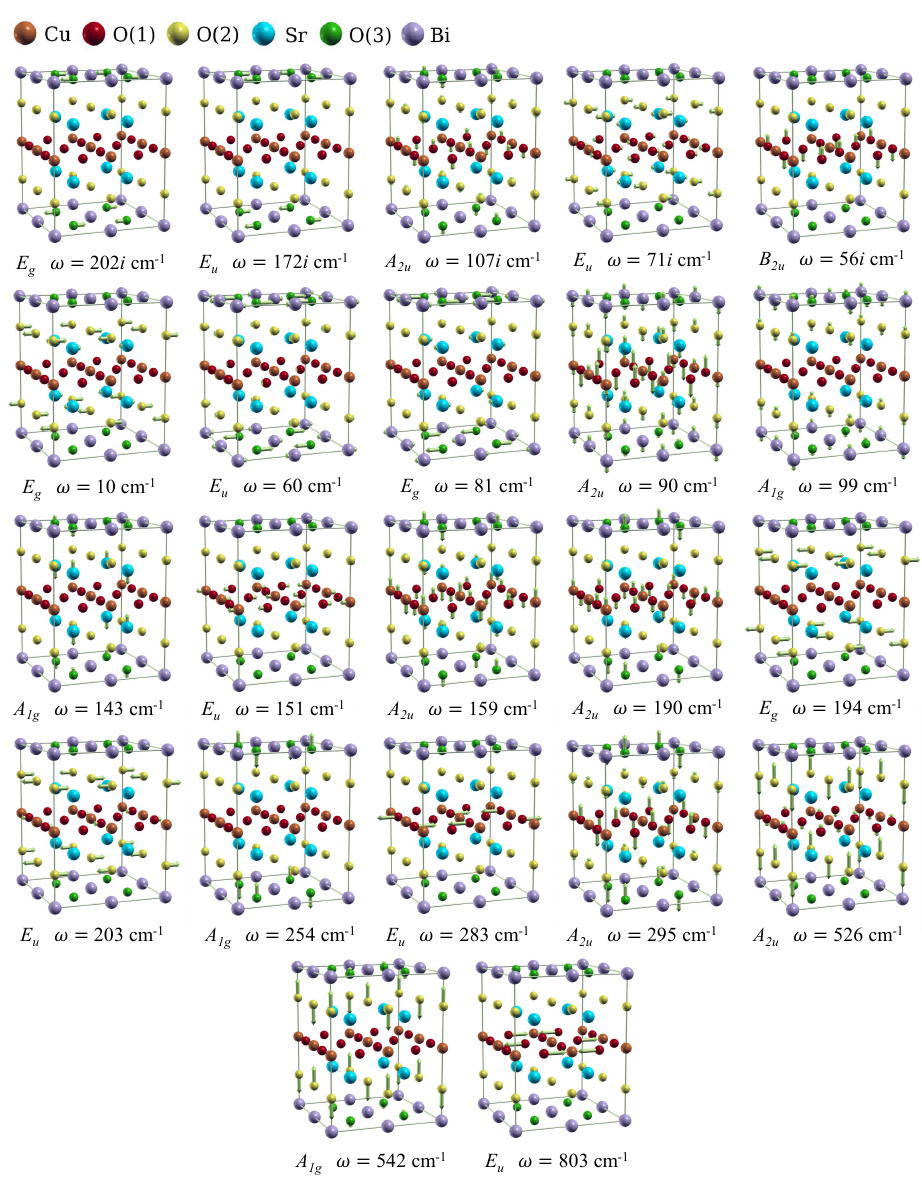
Figure A6: All Bi2201 modes at the M